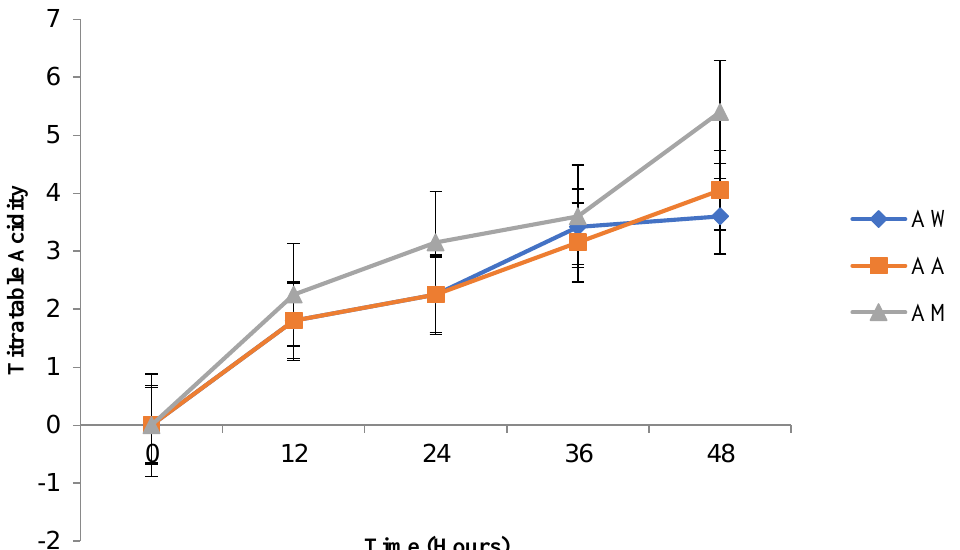
Figure 10. Effect of L. fermentum on the total titratable acidity (TTA) of the beverages. The acidity of the synbiotic beverages increased after 48 h. AW and AA beverages had the highest acid content of 3.60 mg/mL after 48 h. Key: AM—baobab fruit pulp and milk beverage; AA—baobab fruit pulp and apple juice beverage; AW—baobab fruit pulp and apple juice beverage.